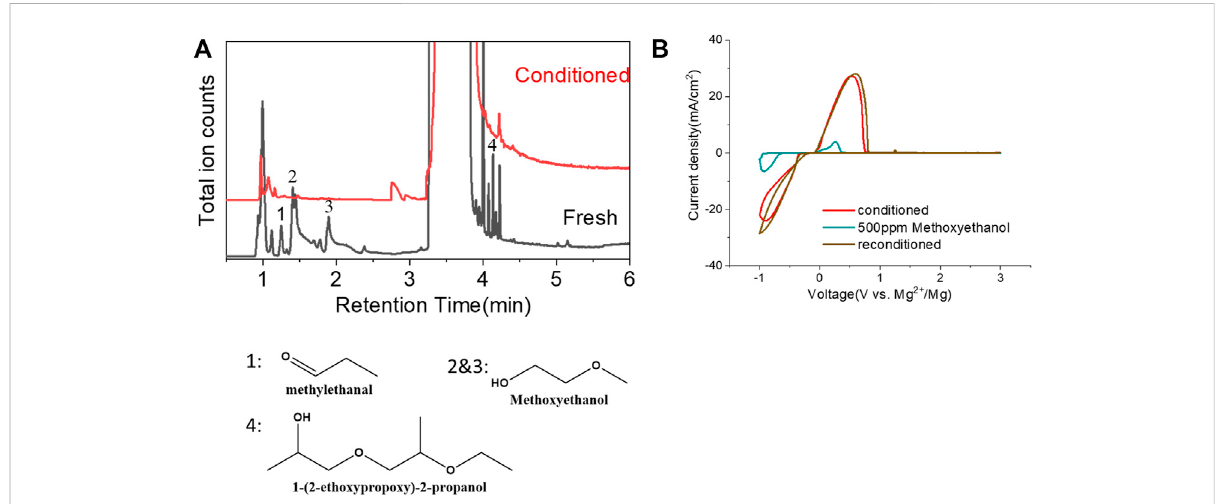
FIGURE 7 (A) Chromatograms (total ion count) of the distilled solvents G2 for the fresh electrolyte and conditioned electrolyte by GC-MS. (B) CV measurement before and after intentionally adding 500 ppm methoxyethanol in the conditioned solution. The performance is restored to the conditioned values after performing conditioning again. Scan rate: 25